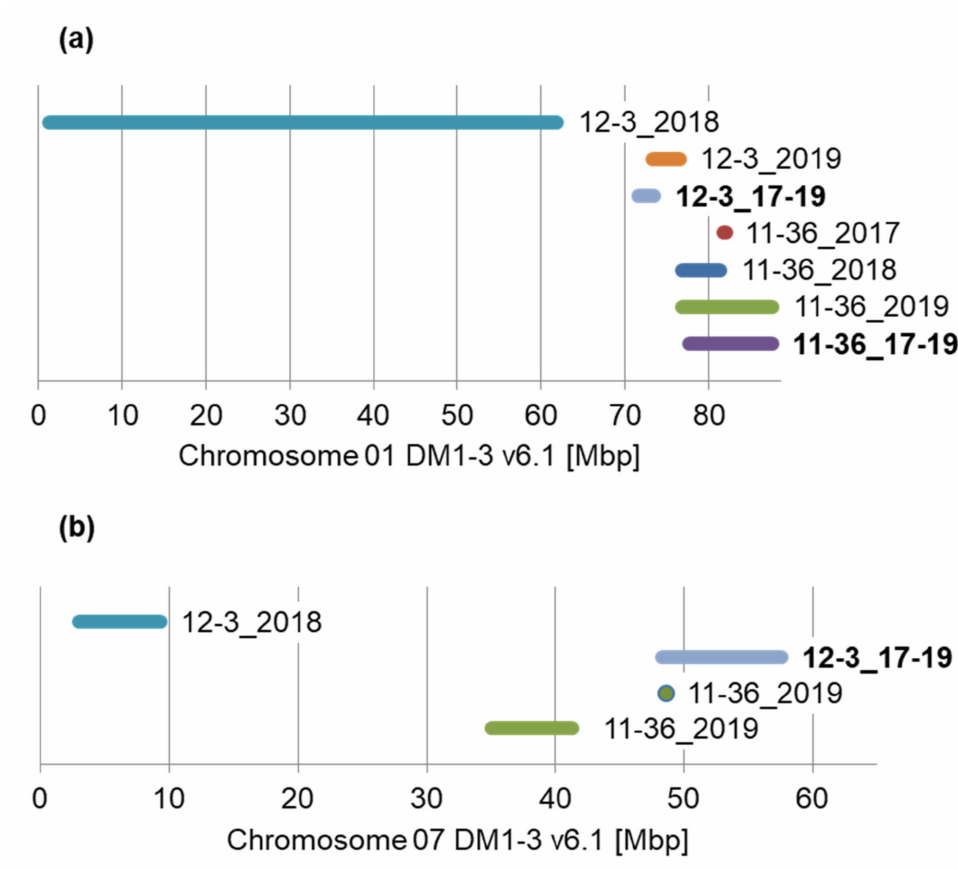
Figure 2. Projection of positions of QTL for dry rot resistance detected using diploid potato popu- lations 11–36 and 12–3 on reference genome assembly S. tuberosum Group Phureja DM1-3 v6.1 [33], chromosomes 01 ( a ) and 07 ( b ). QTL are represented as horizontal bars color-coded according to datasets and tagged with the name of population followed by a dataset: year or ’17–19 (cid:48) (mean, 3-year dataset), in which they were